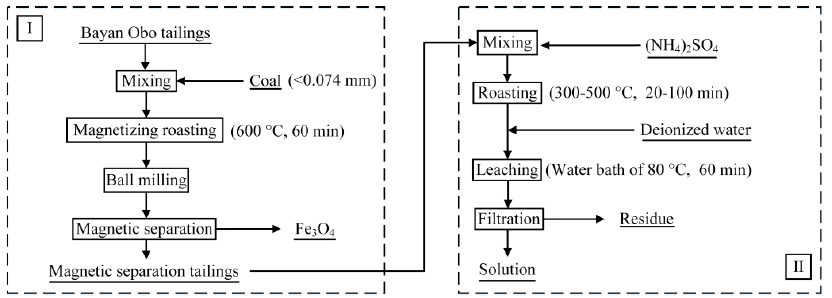
Figure 4. The process flow of the experiments.